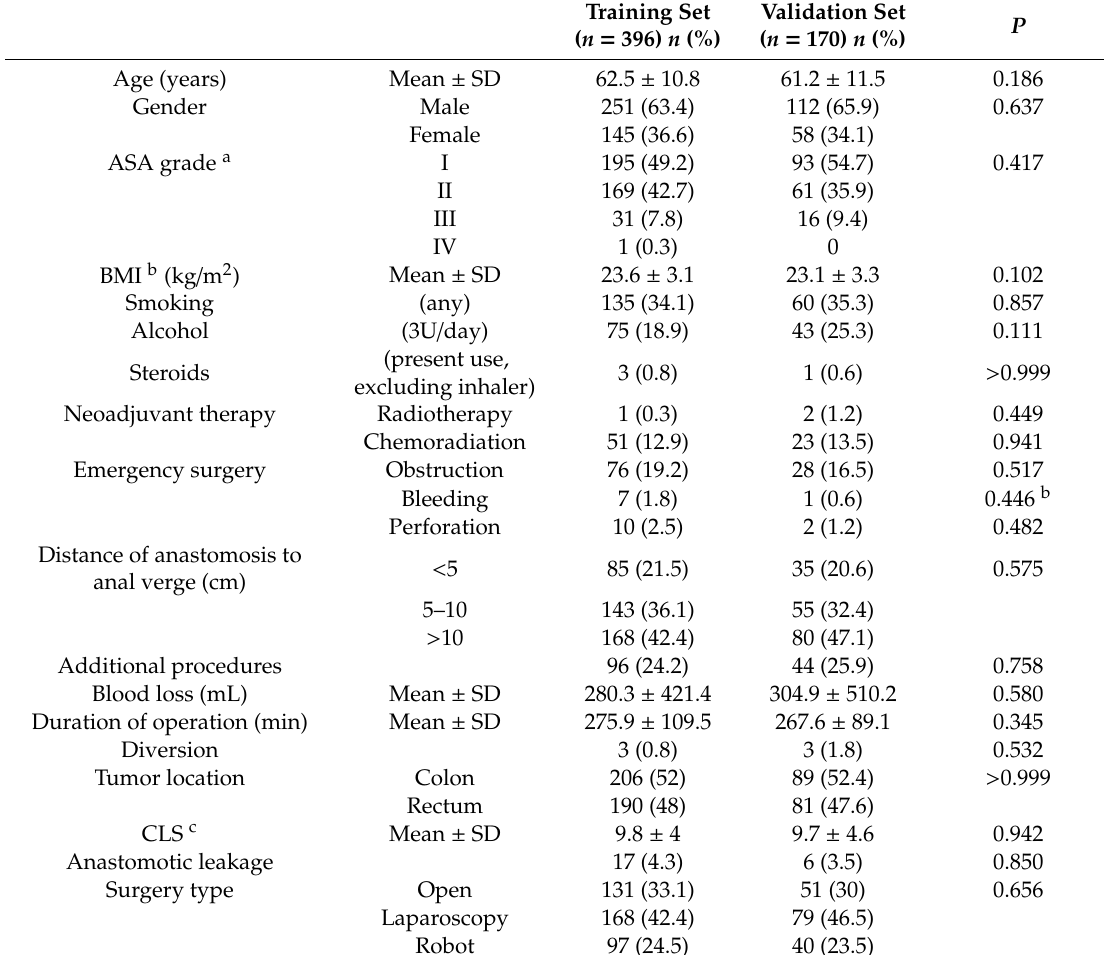
Table 2. Patient demographics and operative outcomes between the training set and the validation